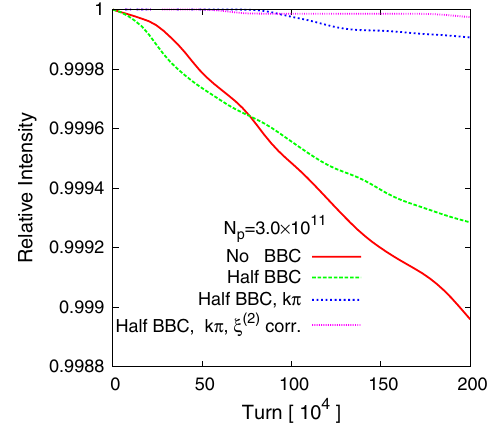
FIG. 19. Relative proton beam losses in 2 (cid:2) 10 6 turns for the proton bunch intensity 3 : 0 (cid:2) 10 11 without beam-beam compen- sation, with half beam-beam compensation, with the betatron phase advance adjustment, and with the global second order chromaticity correction.